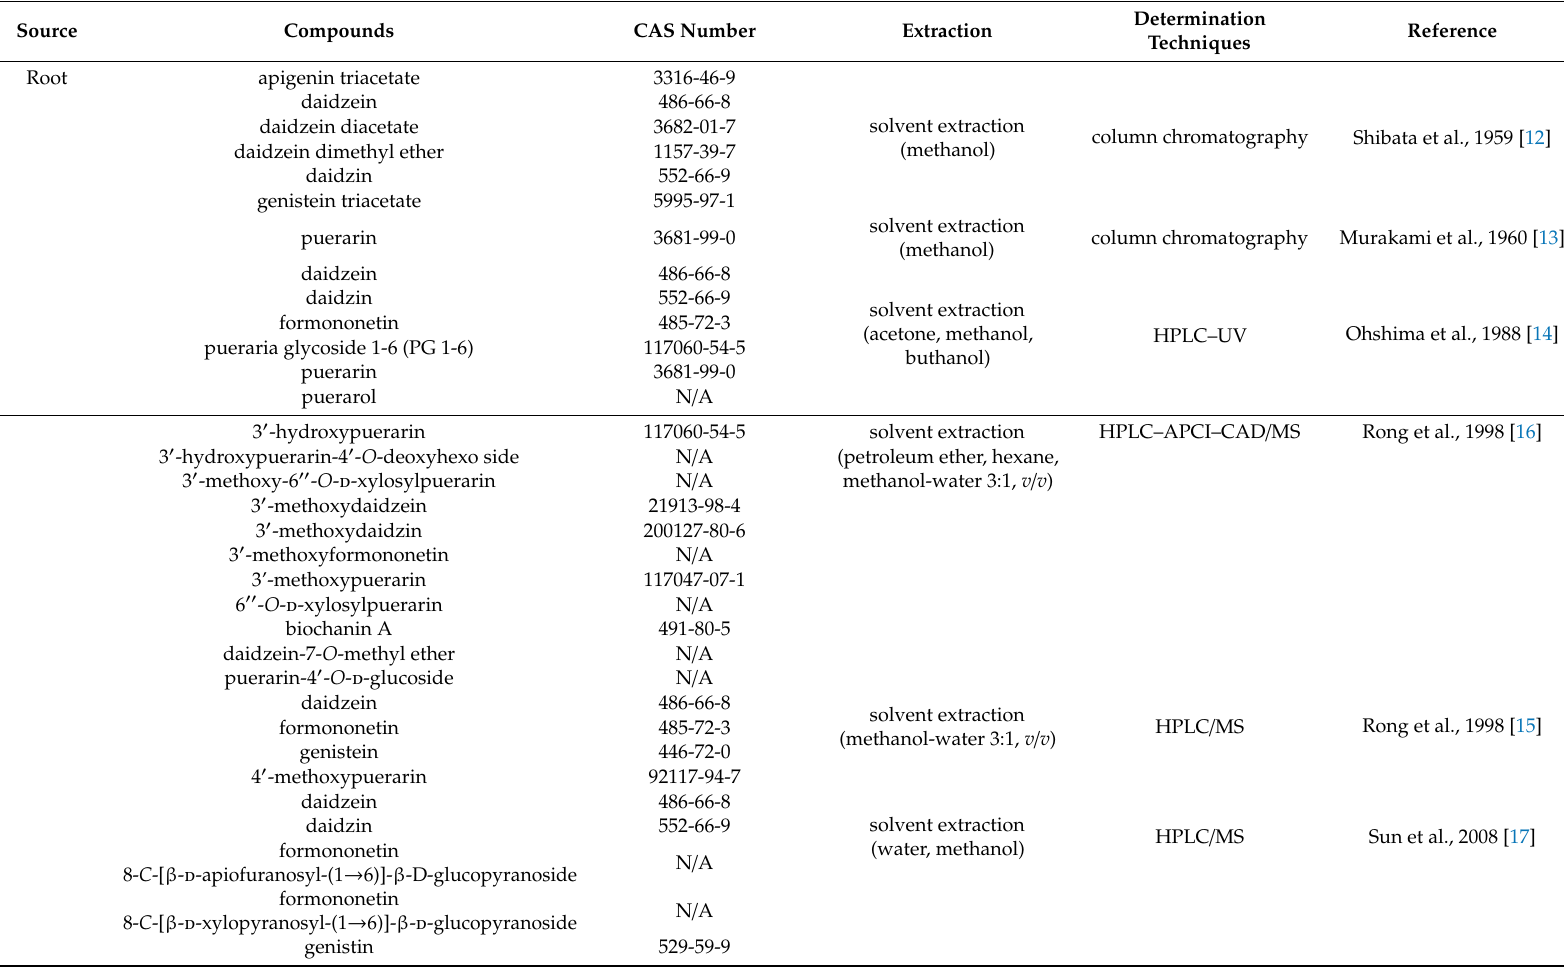
Table 2. Flavonoid phytochemical compounds and some interesting phenolics found in roots, flowers, and leaves of